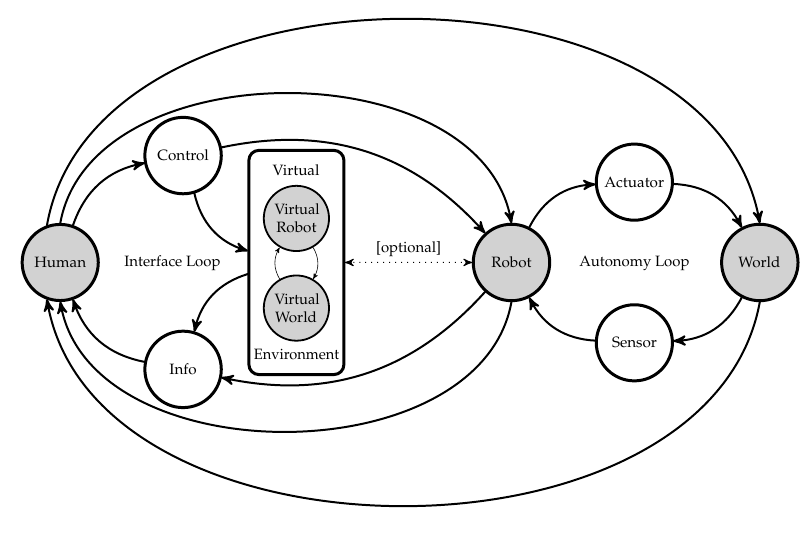
Figure 5. Mixed reality robot operation (inspired by the remote robot operation by Crandall et al.